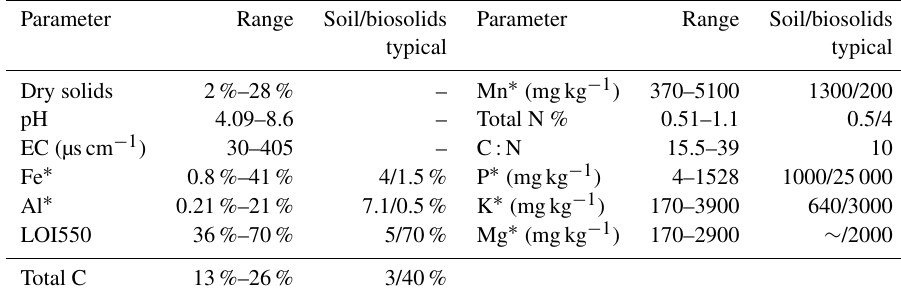
Table 1. Summary of WTR characteristics NE UK (Finlay, 2015). ∗ Pseudo-total metals measured by aqua regia digestion. Total and inorganic carbon measured by Thermo TOC1200. Due to < 0 . 1% inorganic C, total C represents organic C content of